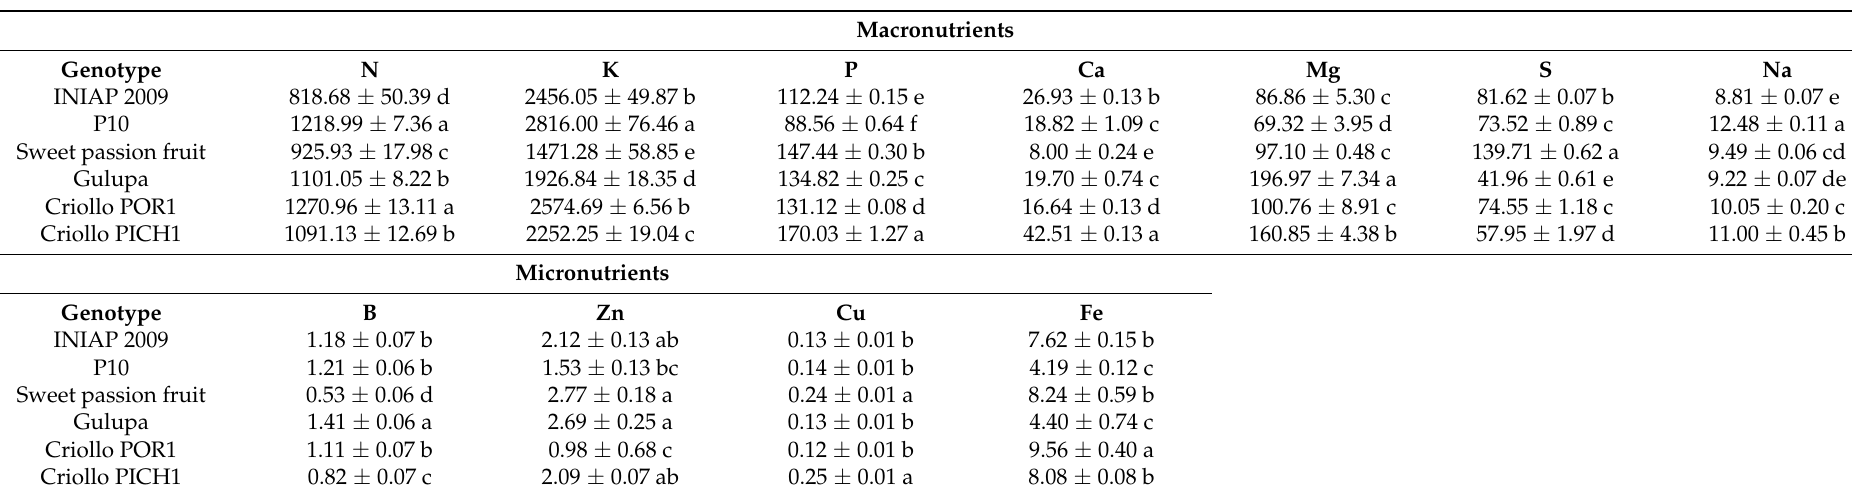
Table 2. Macro and micronutrient content in pulp of passion fruit germplasm grown in Ecuador. Values are expressed mg 100 g (DW) pulp − 1 .